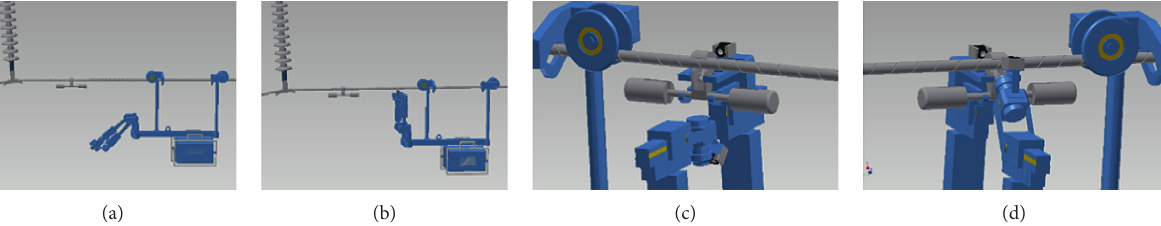
Figure 4: Entity motion simulation of the damper replacement robot. (a) Initial posture. (b) Working posture. (c) Fixing bolt head. (d) Bolt tightening